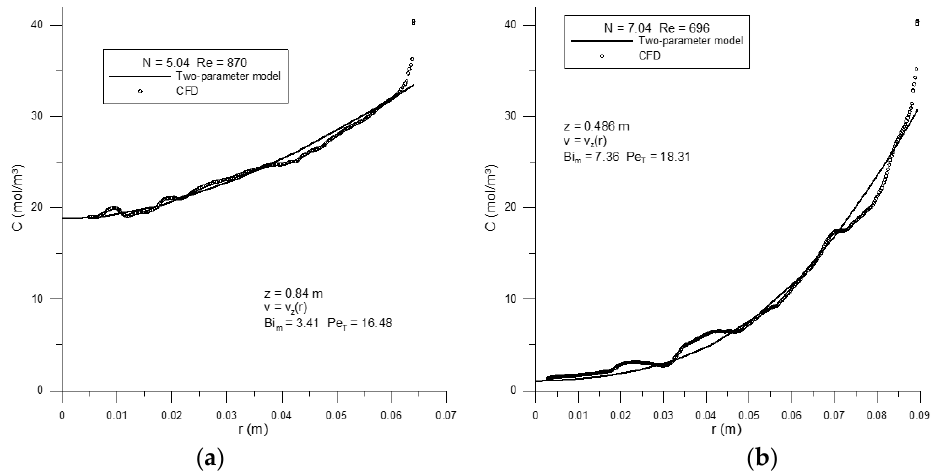
Figure 8. Representative comparisons of fits of the 2-parameter model using constant D T and k m to simulated data from Validation of Computational Fluid Dynamics (CFD), for ( a ) N = 5.04 and Re = 870, and for ( b ) N = 7.04 and Re = 696.